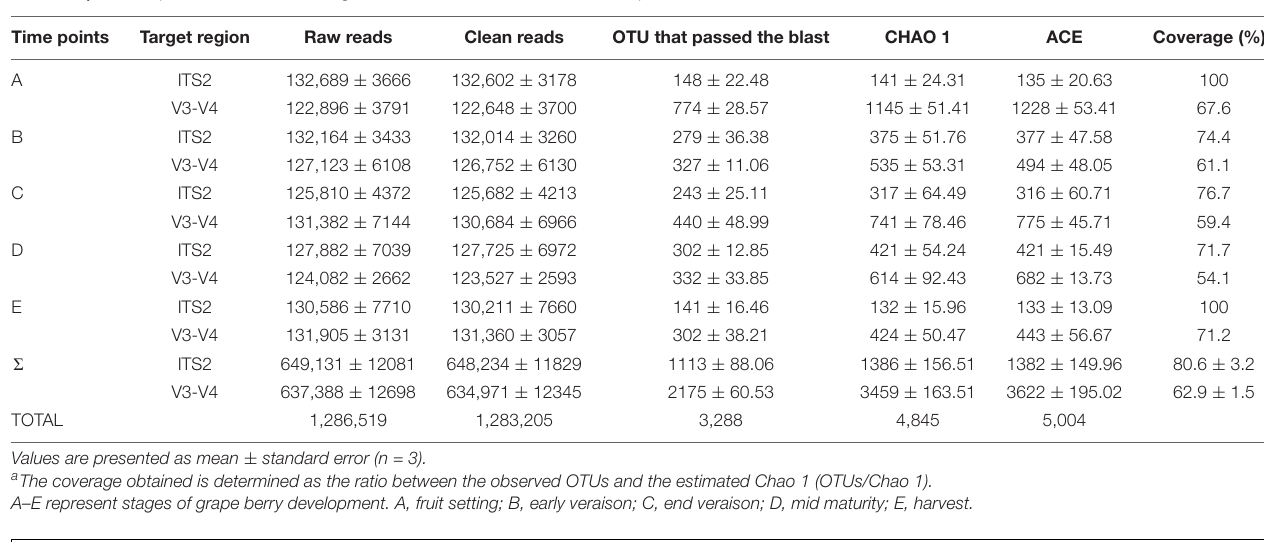
TABLE 1 | Total sequences obtained for fungi and bacterial communities for all